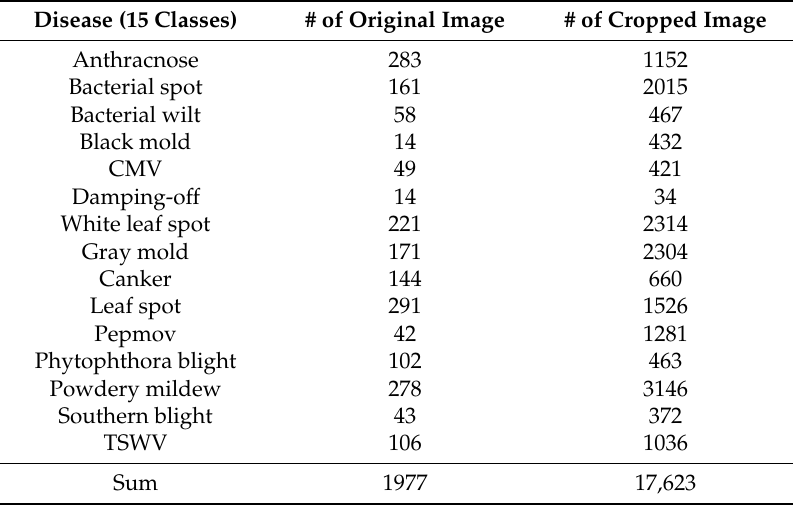
Table 1. Summary of hot pepper disease dataset.